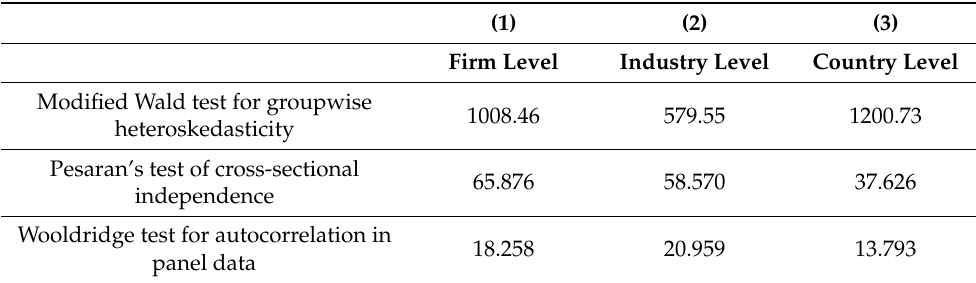
Table 3. Diagnostic